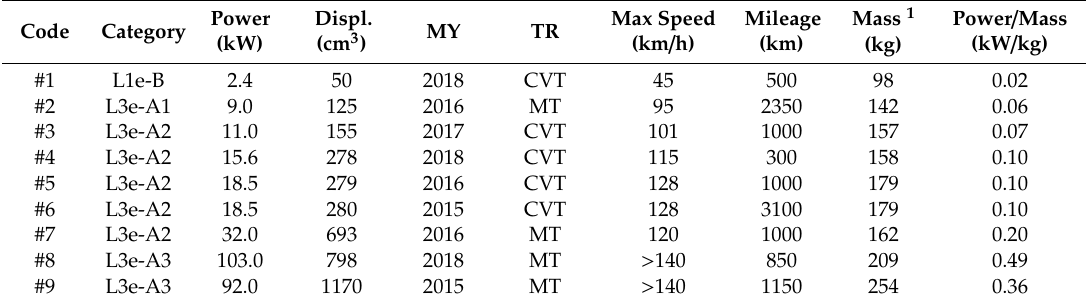
Table 1. Characteristics of the Powered Two-Wheelers (PTW). All Euro 4 gasoline 4-stroke engines with port fuel injection and three-way catalyst as exhaust after-treatment. Fuel E5.